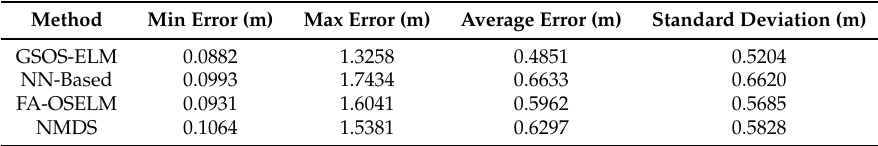
Table 9. Comparison Result under Dynamic Realistic